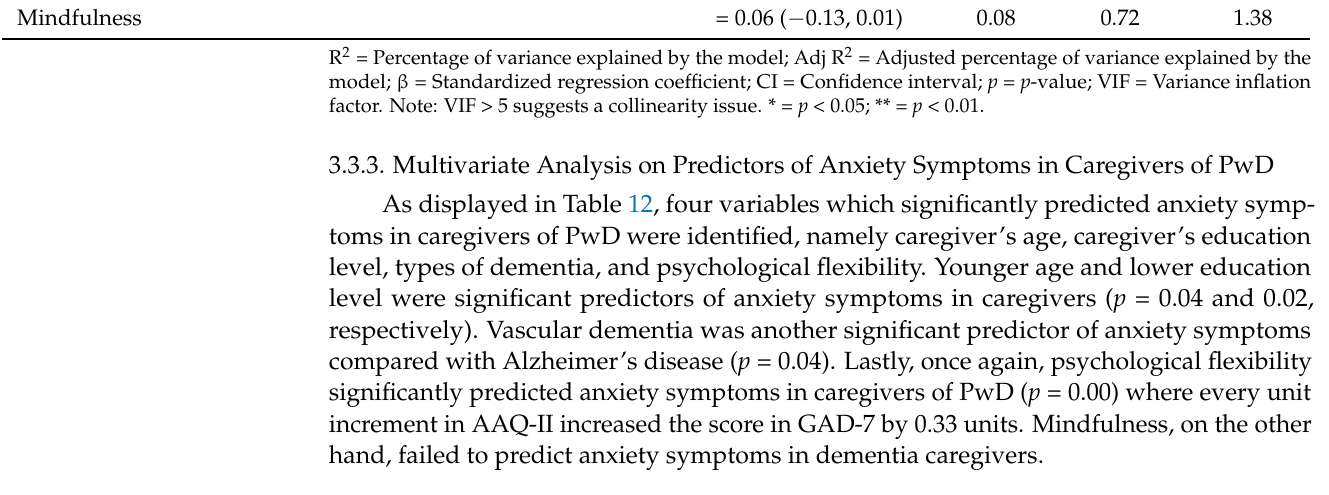
Table 12. Hierarchical General Linear Model Analysis for Predictors of Anxiety Symptoms in Caregivers of